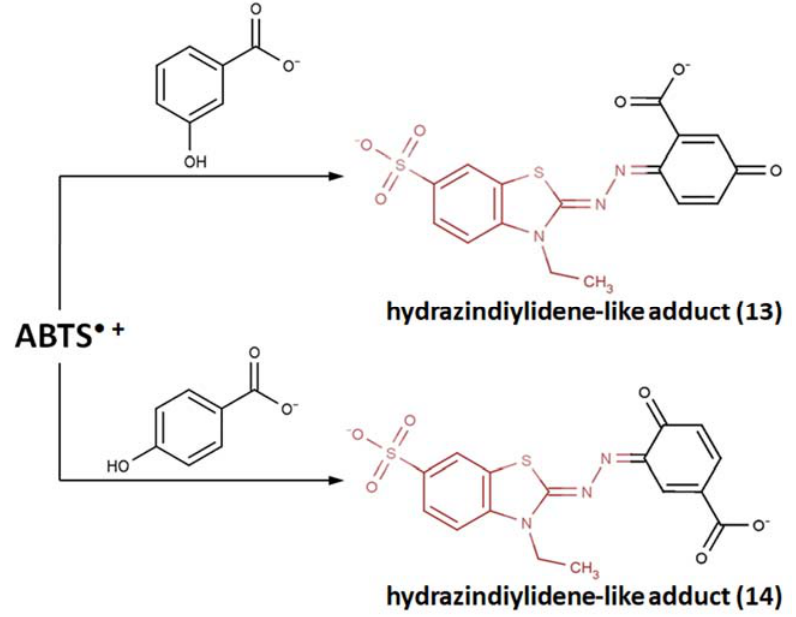
Figure 6. Reaction pathways of ABTS • + with 3-hydroxybenzoic acid and 4-hydroxybenzoic acid [115]. Copyright 1986, adapted with permission from Taylor and Francis.